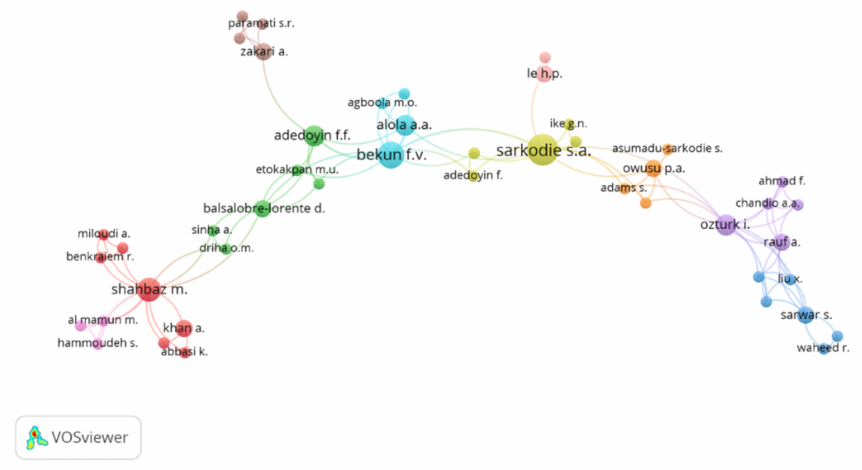
Figure 9. Authors’ Network